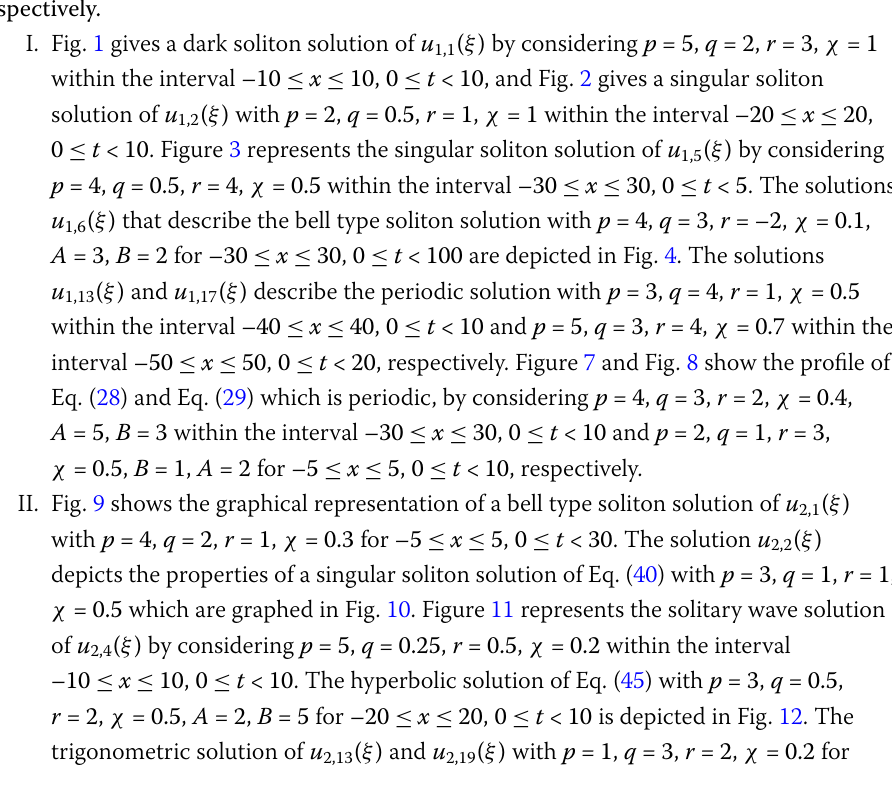
for 3D graphical representation, we have opted for α = 0.4,1, depicted in Figs. 1–14, re-